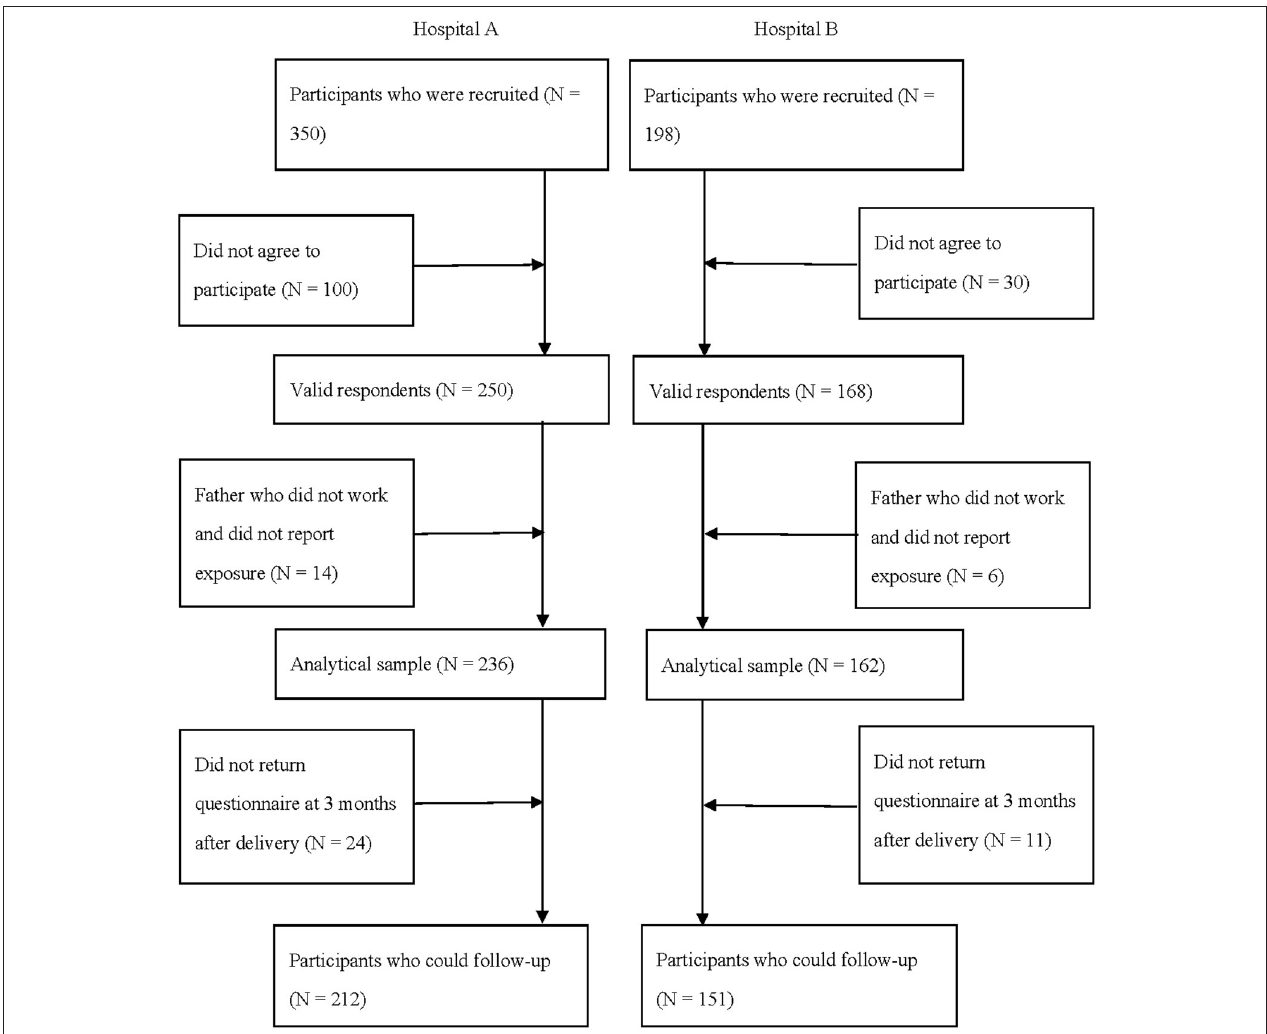
FIGURE 1 | Participant flow